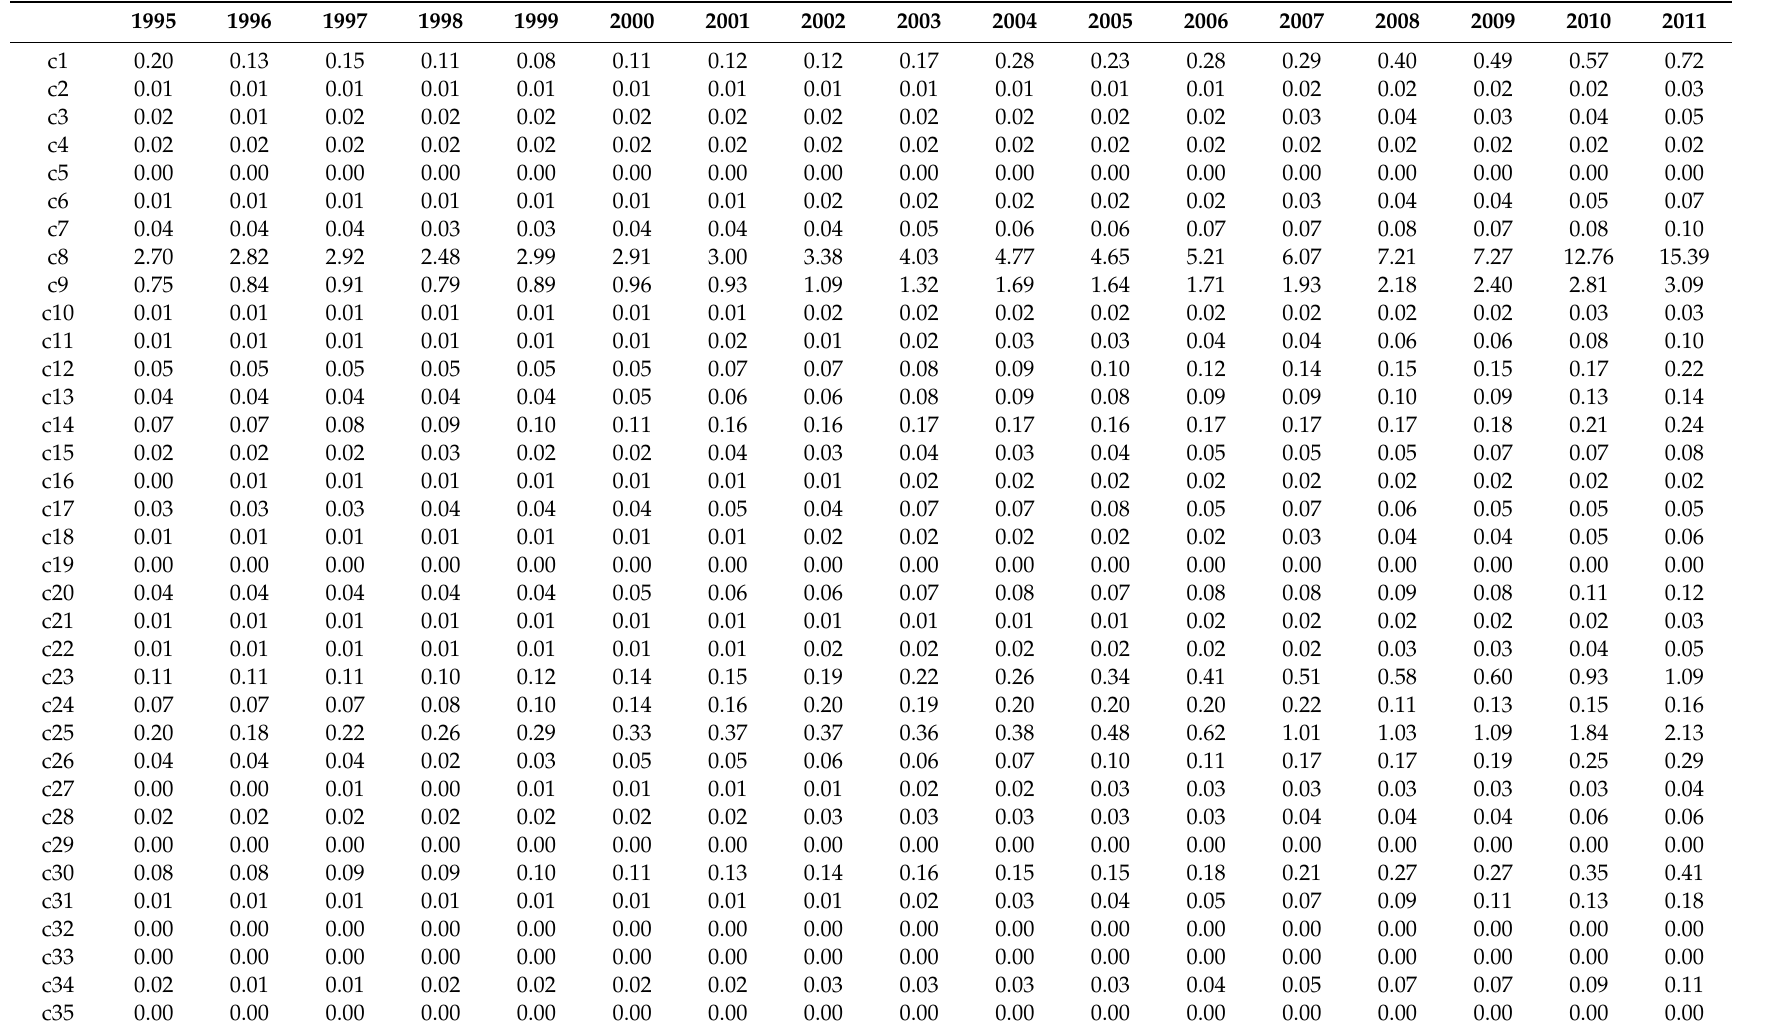
Table A7. The oil consumption embodied in the US’s inter-industry exports to China